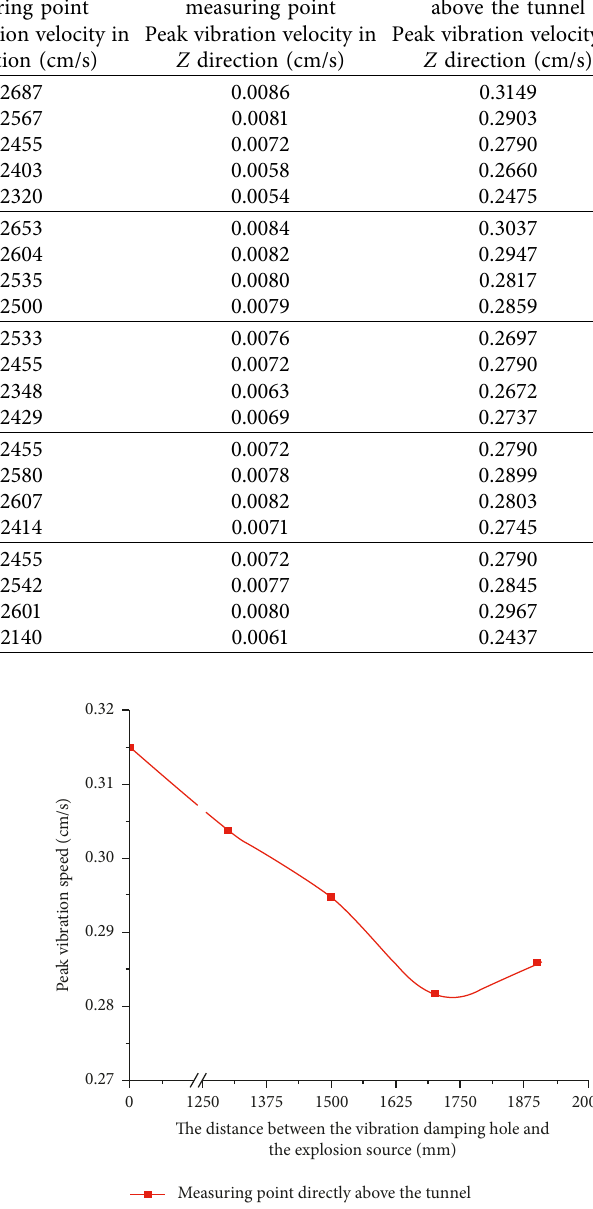
Figure 7: The distance between the damping hole and the ex- plosion source vs. peak vibration velocity.